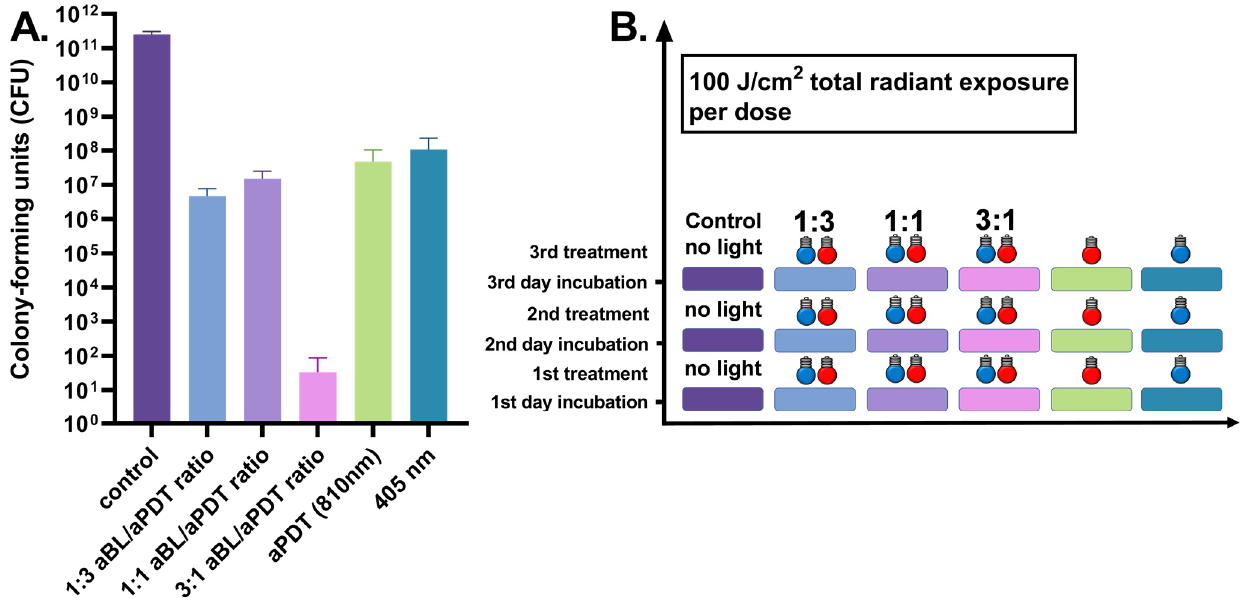
Figure 3. ( A ). Effects of different irradiance ratios of aBL and aPDT in the dual-light aPDT system in three-day S. aureus biofilm, when the antibacterial treatment is given once daily. Three-day S. aureus biofilm, daily dose, aBL vs. dual-light 1:3 aBL/aPDT ratio, p = 0.0022; aBL vs. dual-light 1:1 aBL/aPDT ratio, p = 0.015; aBL vs. dual-light 3:1 aBL/aPDT ratio, p = 0.0022; aPDT vs. dual-light 1:3 aBL/aPDT ratio, p = 0.0043; aPDT vs. dual-light 1:1 aBL/aPDT ratio, p = 0.015; aPDT vs. dual-light 3:1 aBL/aPDT ratio, p = 0.0022; aBL vs. aPDT, p = 0.26; dual-light aPDT: 1:3 aBL/aPDT ratio vs. 1:1 aBL/aPDT ratio, p = 0.03; 1:3 aBL/aPDT ratio vs. 3:1 aBL/aPDT ratio, p = 0.0022; 1:1 aBL/aPDT ratio vs. 3:1 aBL/aPDT ratio; p = 0.0022. The y -axis displays the median of CFUs. Six assays were performed for each experiment, and the control biofilm was performed in three assays. The 95% confidence interval (CI) is presented by using t-bars. ( B ). A schematic representation of the experiment.